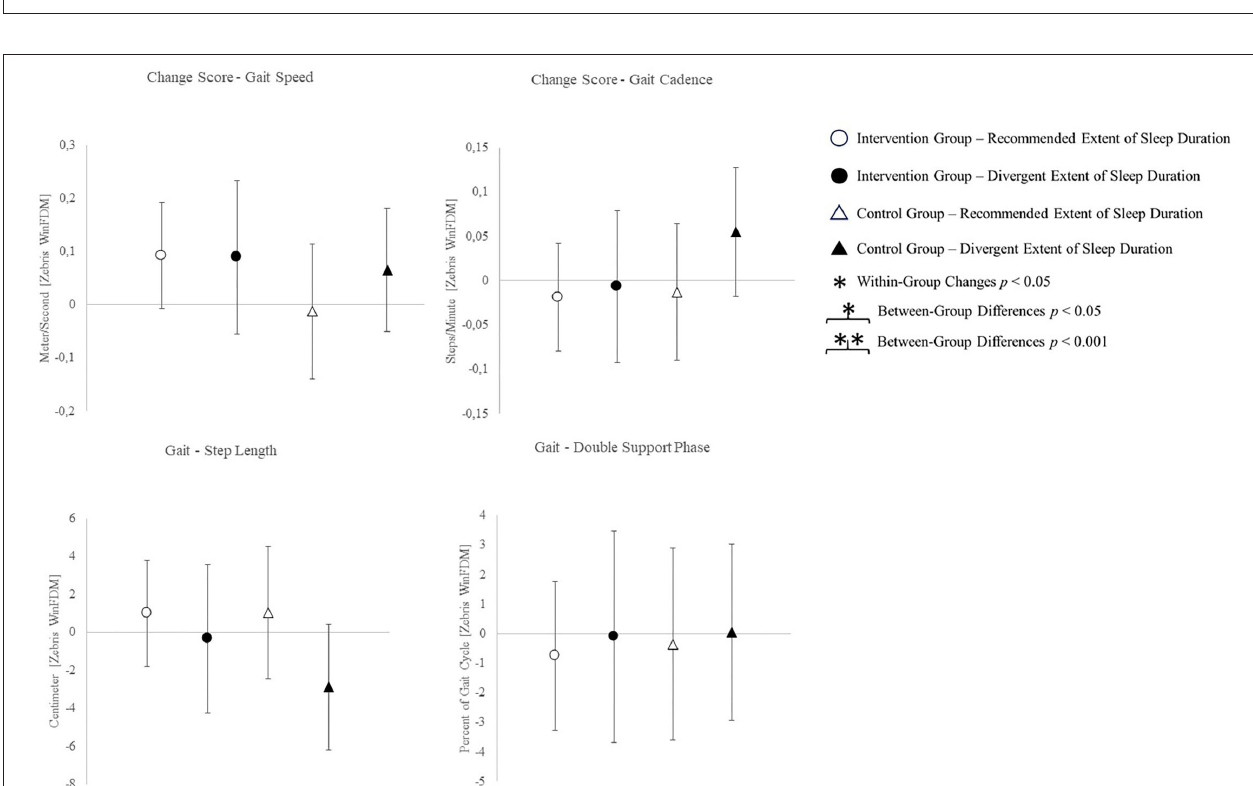
FIGURE 3 | Change scores of secondary outcomes measured by functional-reach and chair-rise test.